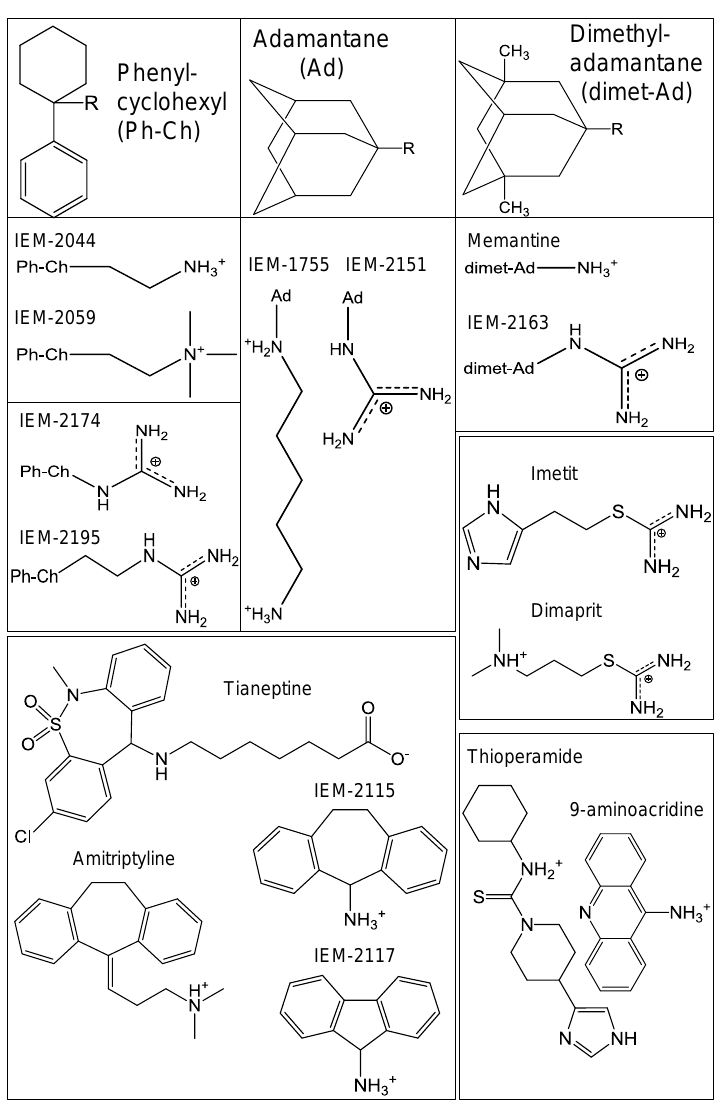
Figure 1. Chemical structure of the tested compounds. The first row represents common hydrophobic moieties (Ph-Ch, Ad, and dimet-Ad) of IEM compounds and memantine, with their terminal radicals (R) shown directly